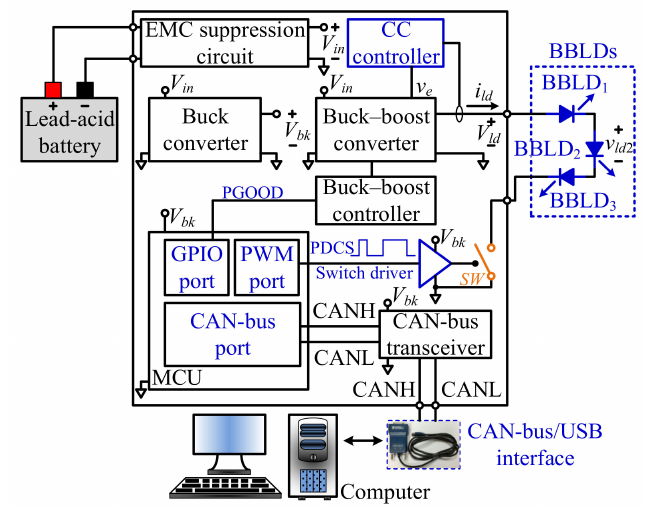
Figure 1. The function block of the laser headlight electrical system